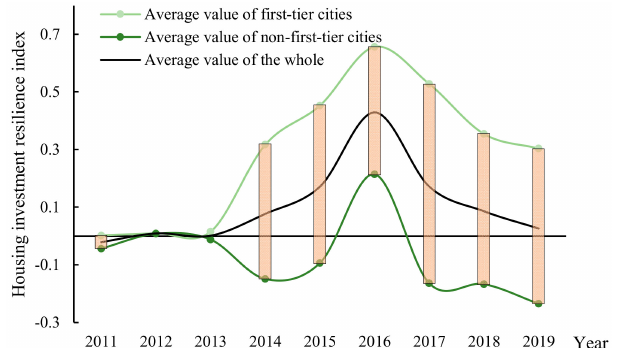
Figure 3. Time series evolution of urban housing investment resilience,